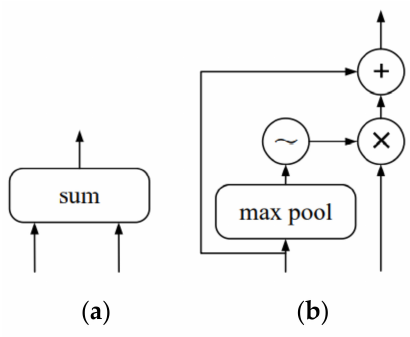
Figure 6. Feature fusion methods: ( a ) sum and ( b ) global pooling.